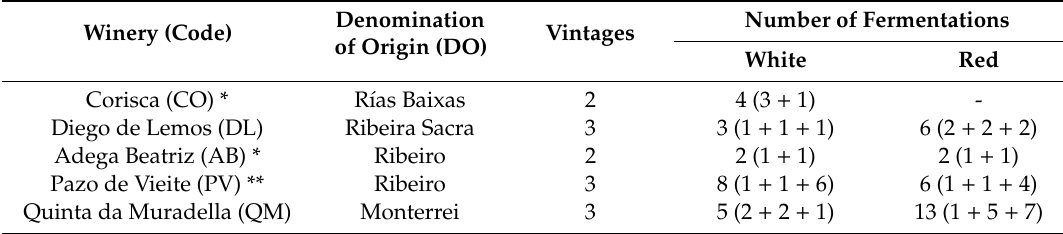
Table 1. Wineries and fermentations sampled in this study. Denomination Vintages Winery (Code) of Origin (DO)